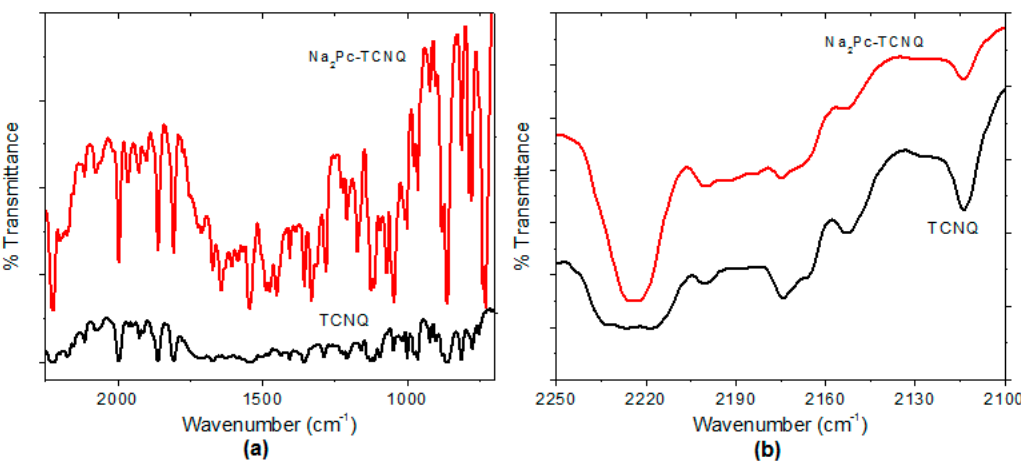
Figure 4. IR spectrum of Na 2 Pc + TCNQ and TCNQ in ( a ) the 700–2250 cm − 1 region and ( b ) the cyano-stretching